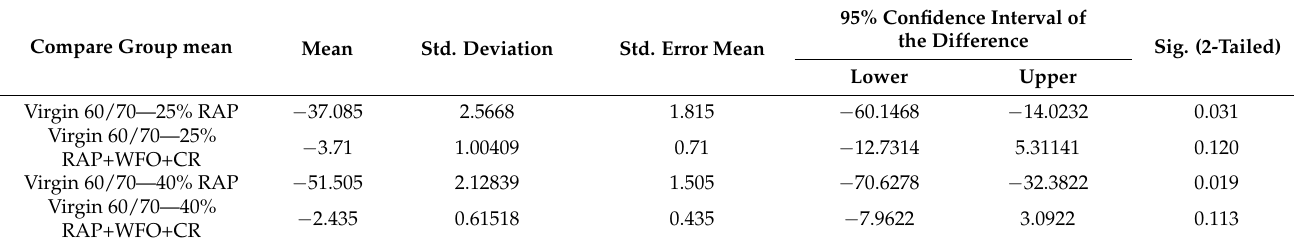
95% Confidence Interval of the